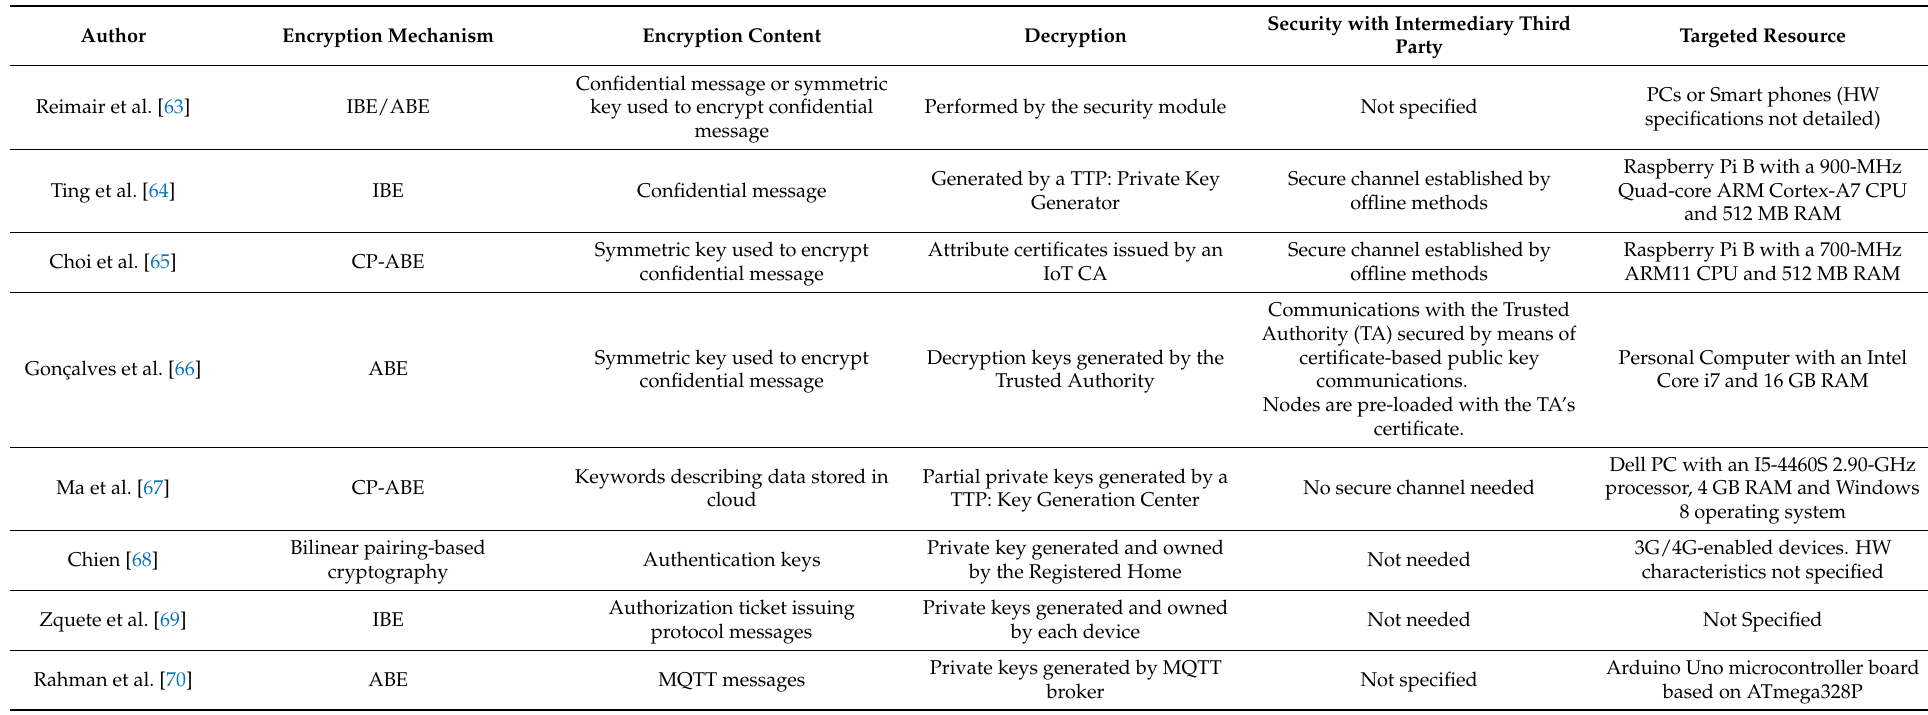
Table 4. Summary of approaches based on using ABE as an alternative to